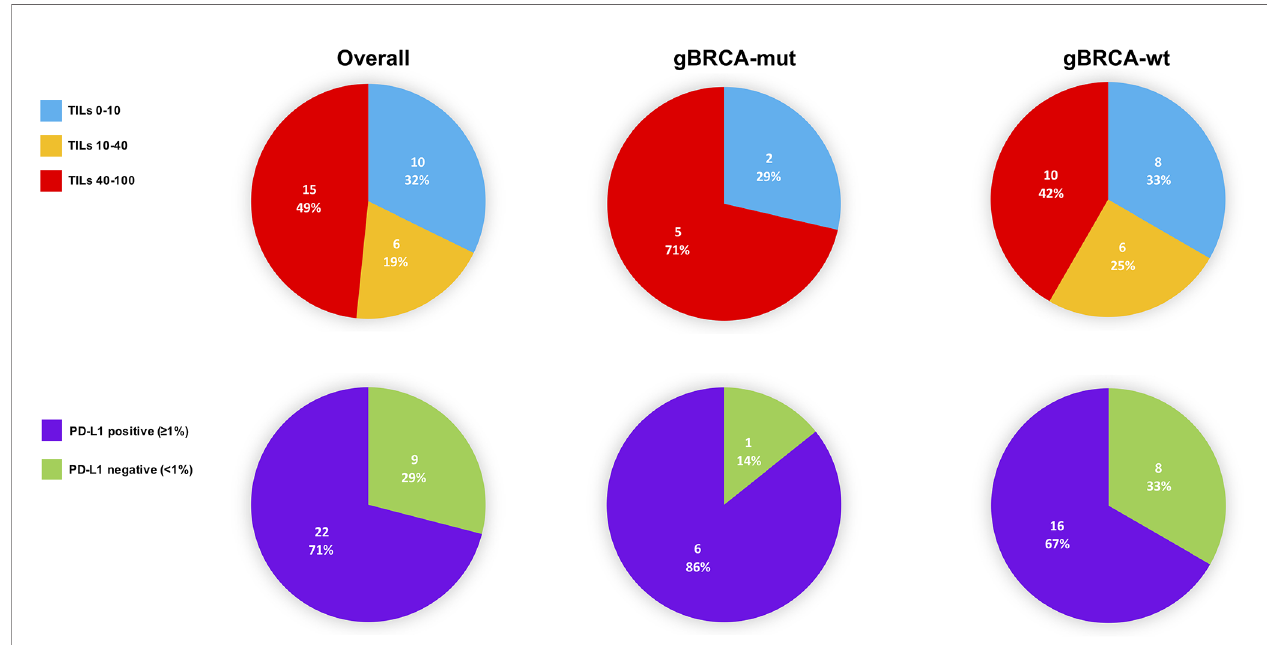
FIGURE 2 | TILs and PD-L1 distribution in the overall population, g BRCA -mutant and wild-type tumors at basal assessment. TILs, tumor-in fi ltrating lymphocytes; g BRCA -wt, germinal BRCA 1/2-wild type triple negative tumors; g BRCA -mut, germinal BRCA 1/2-mutant tumors; PD-L1, PD-L1 in tumor-in fi ltrating in fl ammatory